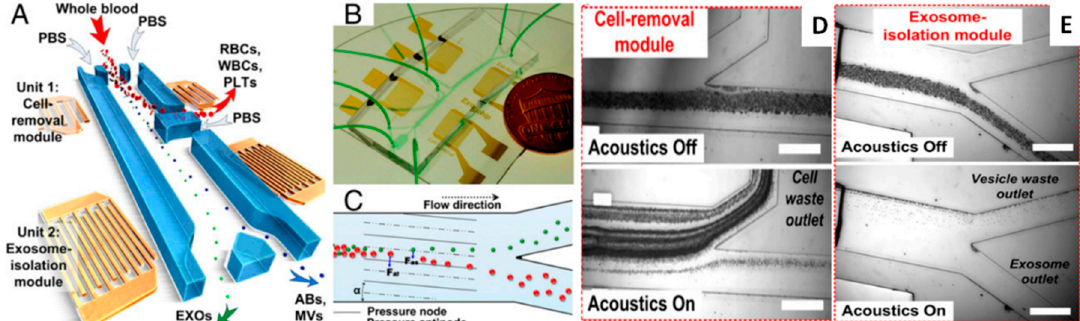
Figure 9. ( A ) Scheme and mechanisms of the acoustofluidic device for isolating exosomes. Red blood cells (RBCs), white blood cells (WBCs), and platelets (PLTs) are removed in the first separation step and then subgroups of EVs (microvesicles, apoptotic bodies and exosomes) are sorted by the exosome-isolation module; ( B ) Optical image of the setup developed by Wu and co-workers; ( C ) Schematic of size-based separation due to the periodic distribution of pressure nodes and antinodes in a surface acoustic waves (SAW) field. Larger particles are pushed toward node planes; ( D , E ) Optical images of the separation steps corresponding to the elimination of blood elements and exosomes collection (Scale bar: 500 µ m). Figure rearranged with permission from reference [184].